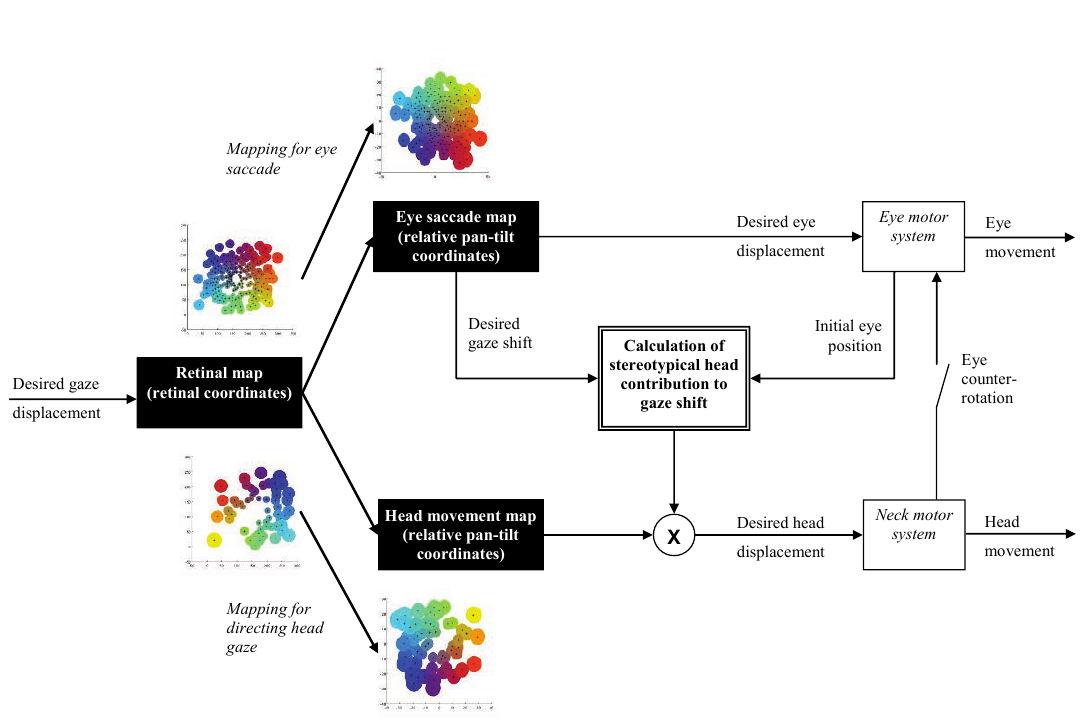
Figure 1. Our gaze control architecture (described fully in [24]). Eye and head control is learnt through a pair of topographic mappings linking stimuli in retinal coordinates to the corresponding motor movements required for fixation. Stereotypical head contributions are calculated from the initial eye position and